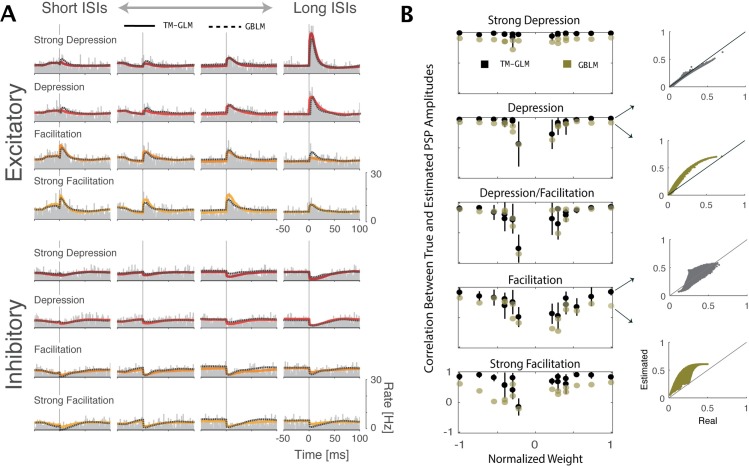
A) For each type of STP, the cross correlations between pre- and postsynaptic spiking split for the quartiles of the presynaptic ISI distribution (columns) from shorter (left) to longer inter-spike intervals (right). The estimated cross-correlation from TM-GLM (solid) and GBLM (dashed) are shown on top of the observed cross-correlation (gray bars). B) The correlation between true and estimated amplitudes of postsynaptic potentials in five different classes of plasticity as a function of the overall synaptic (based on 1000s recording time with 5Hz presynaptic firing rate). The PSPs of depressing synapses tend to be more accurately reconstructed than those of facilitating synapses, and weaker synapses (both excitatory and inhibitory) tend to be less accurately reconstructed than strong synapses.